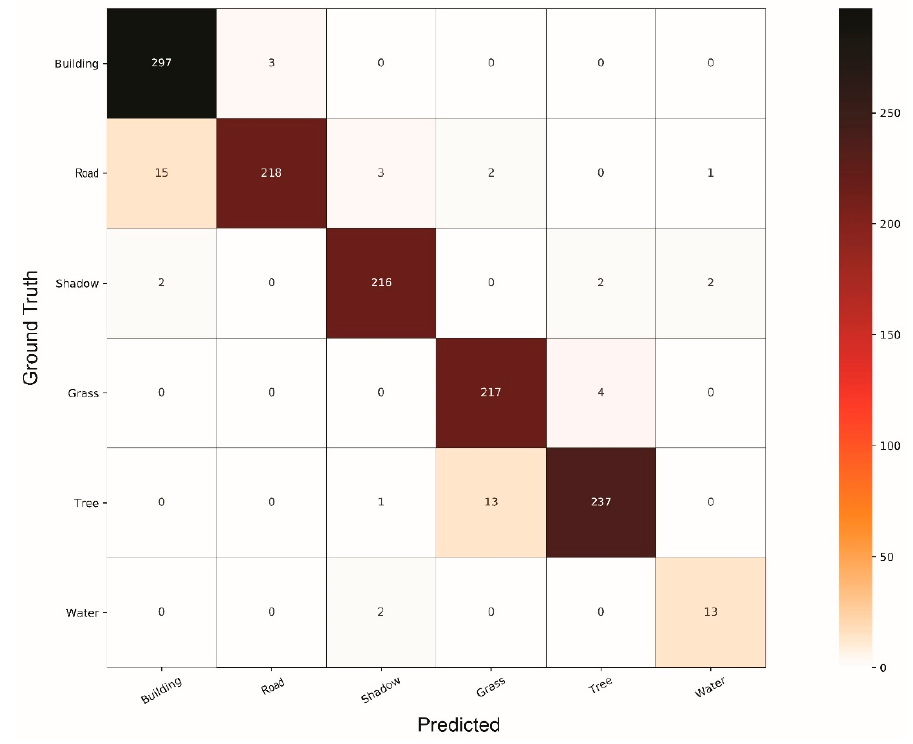
Figure A5. Confusion matrix derived from the GB model for 30 cm image.